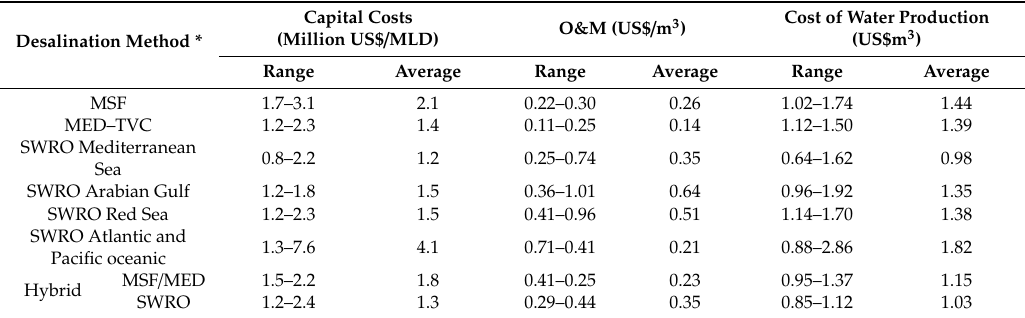
Table 1. Summary of Worldwide Seawater desalination costs